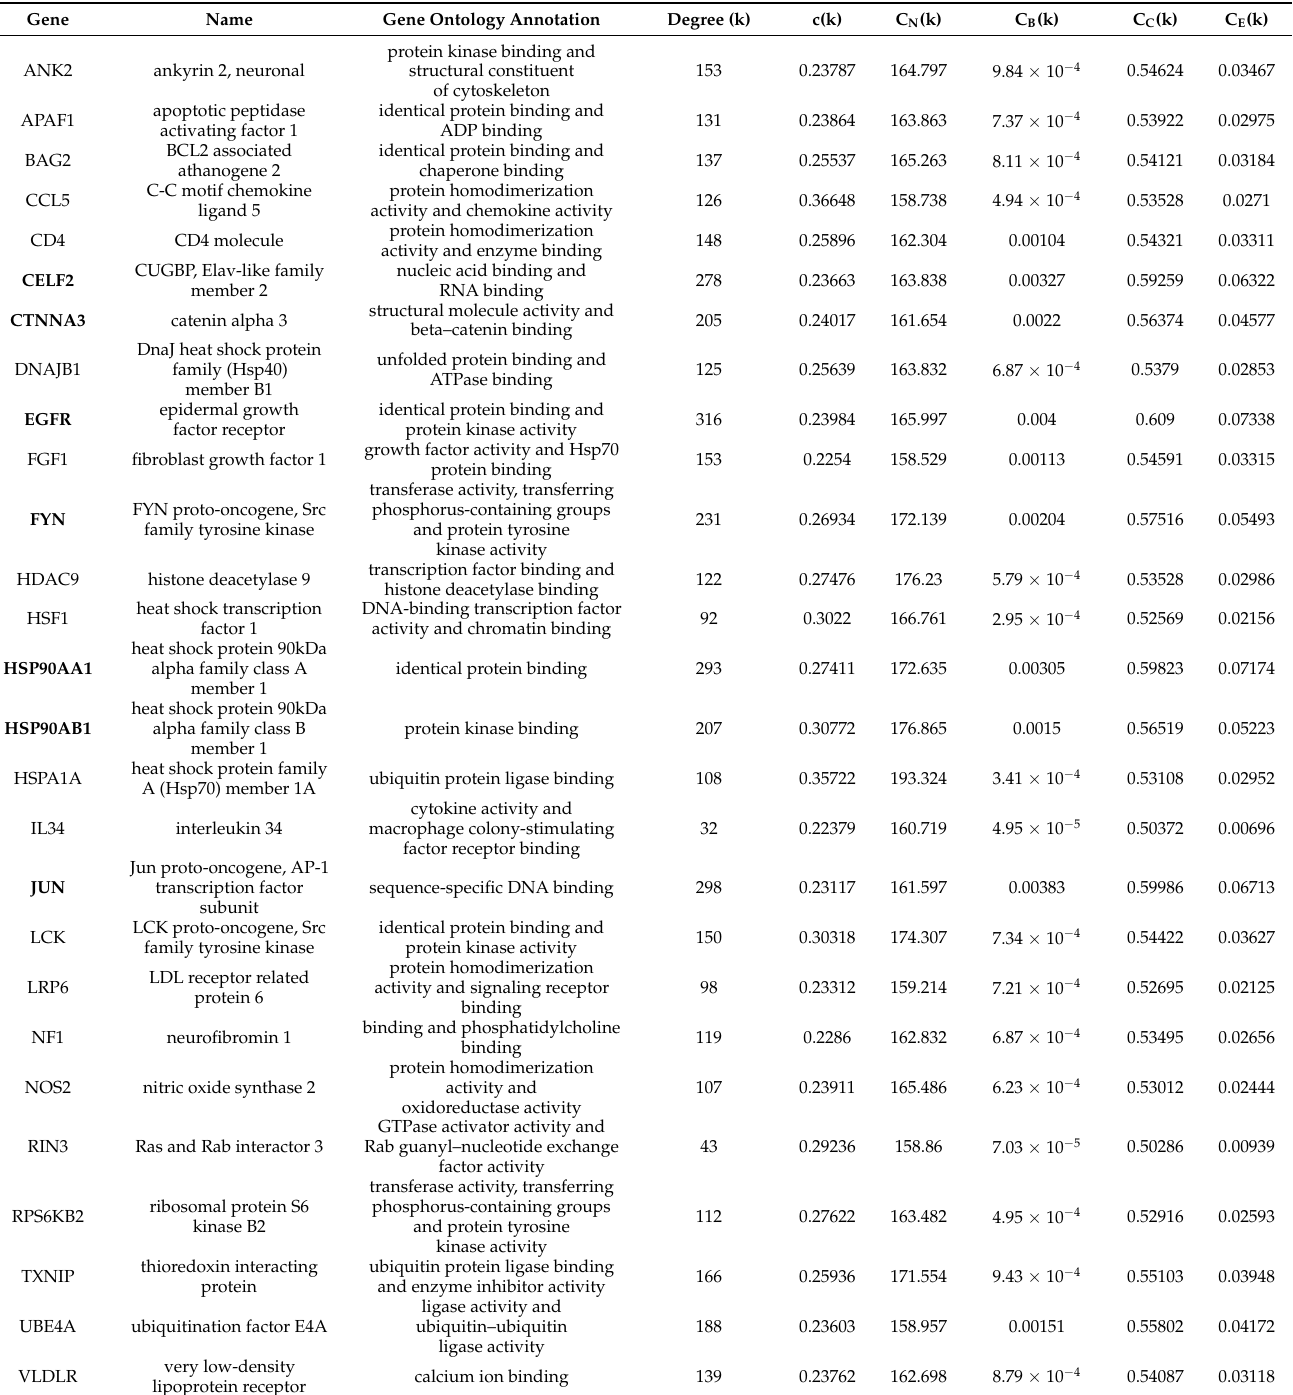
Table 2. Key regulators and genes present with them in motifs at 6th level with topological properties from principal dementia